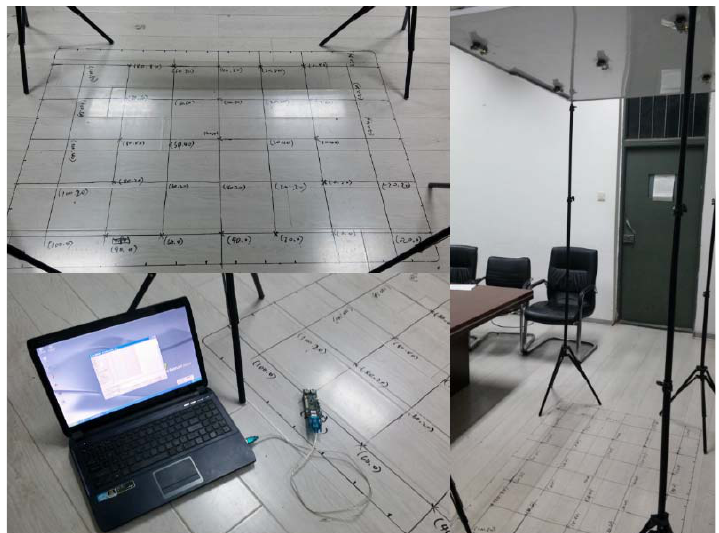
Figure 1. The deployment of the system.